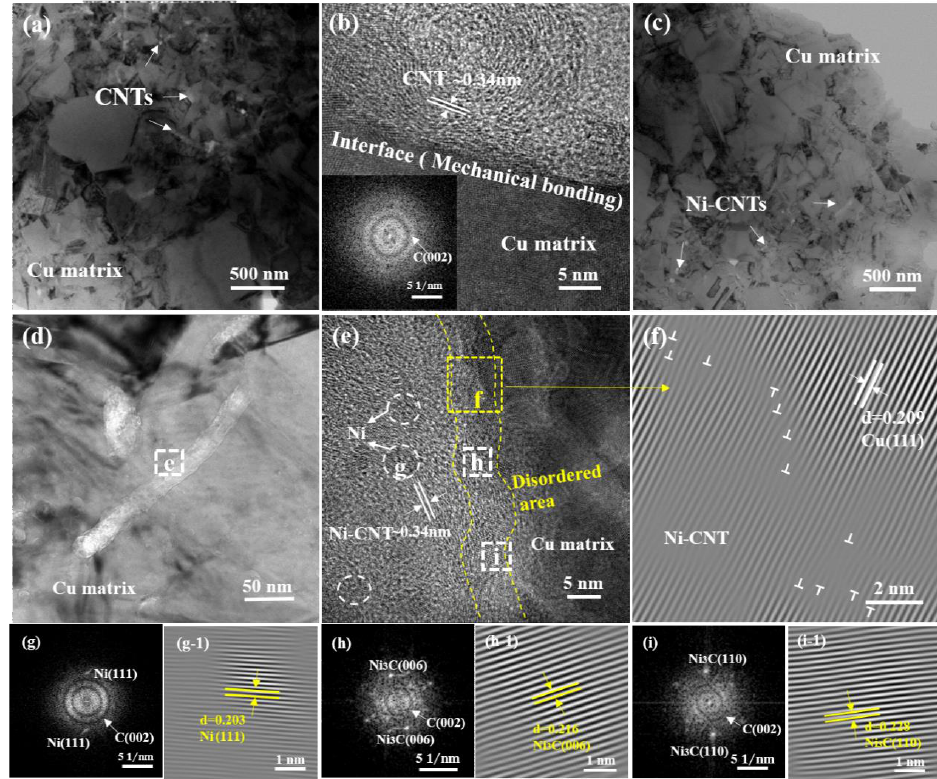
Figure 9. ( a , b ) TEM images of CNTs/Cu f® Cu composite; ( c – e ) TEM images of Ni-CNTs/Cu f® Cu composite; ( f – i ) the corresponding image in the rectangular box of ( e ).